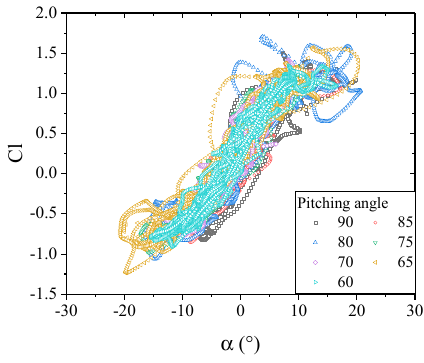
Figure 15. Instantaneous lift coefficients at r/R = 0.64 with different pitching angles.